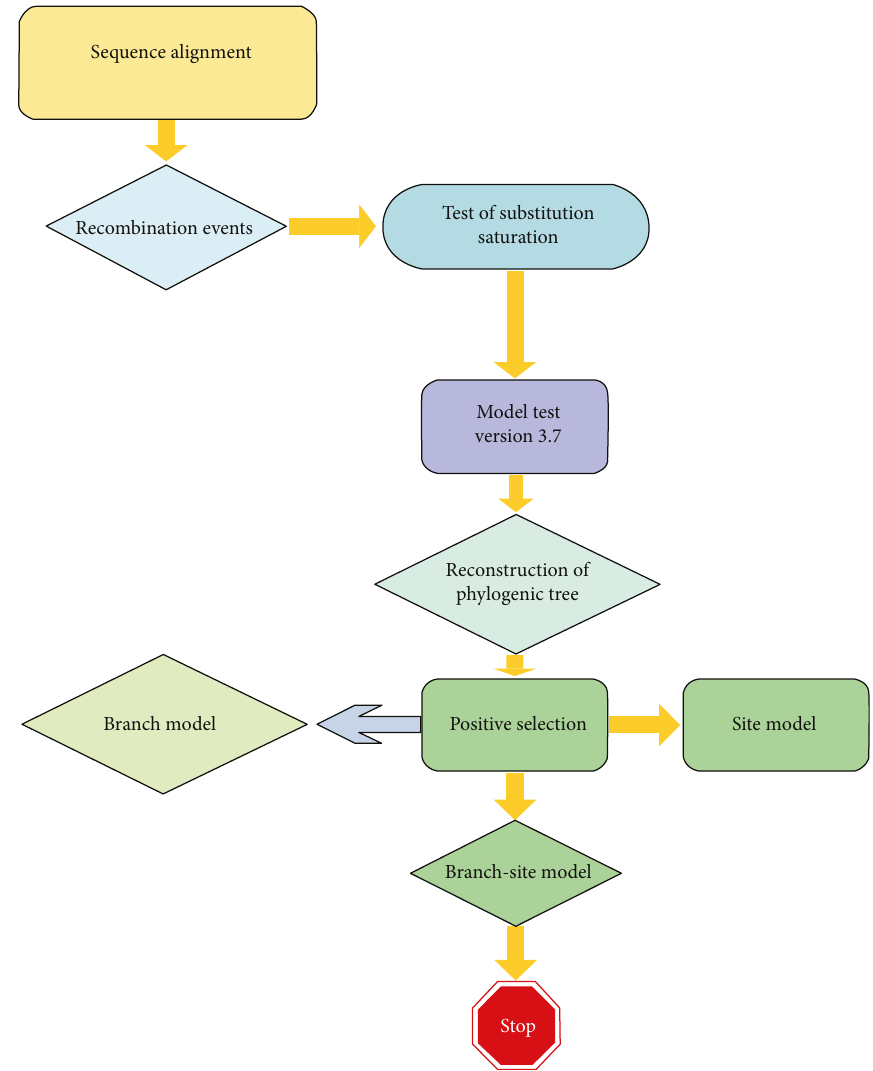
Figure 1: Technical routes of positive selection analysis in the site model, branch model, and branch-site model for SQS sequences in